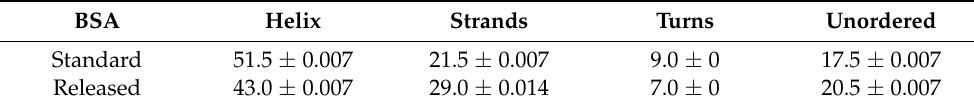
Table 3. The BSA secondary structure released from cationic CHL NPs/NCMPs compared to standard ( n =